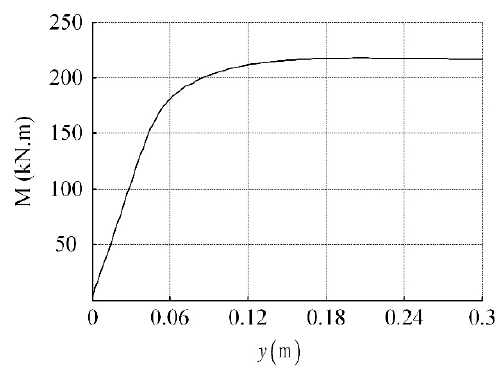
Figure 12. Bending moment change during pipe reeling.